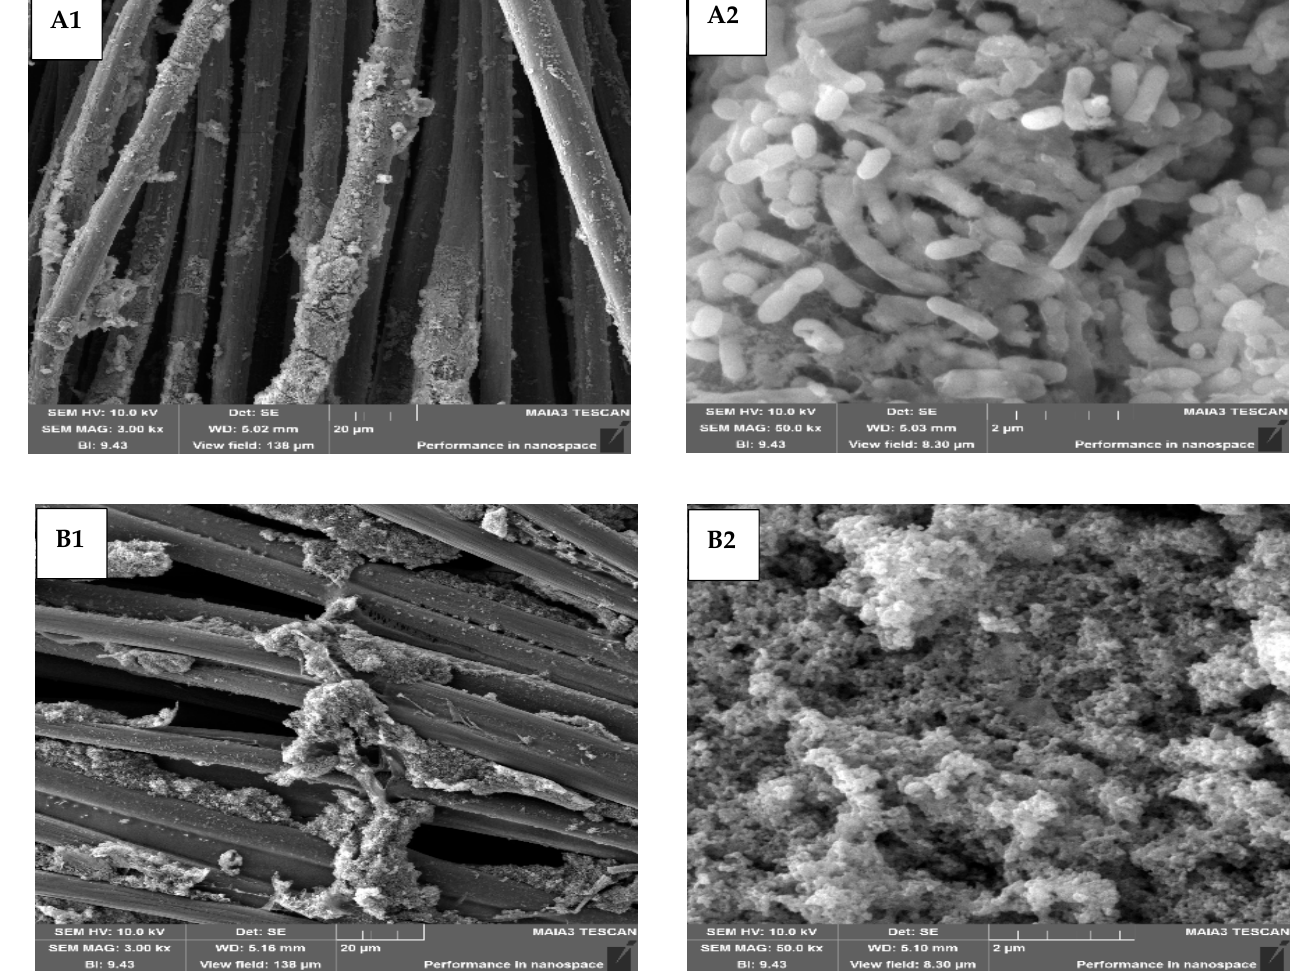
Figure 9. SEM images on the anode of the MEC control ( A1 , A2 ) and the MEC-SBP ( B1 , B2 ). Magnification: 3 kx ( A1 , B1 ) and 50 kx ( A2 , B2 ).